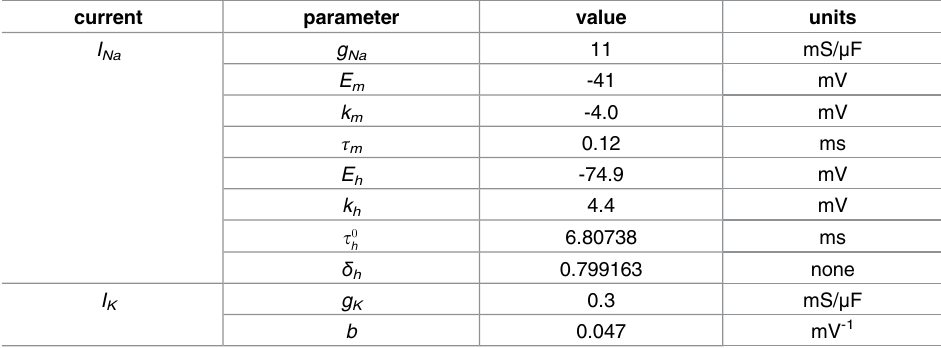
Table 1. Parameter values for “parsimonious rabbit” (PR)